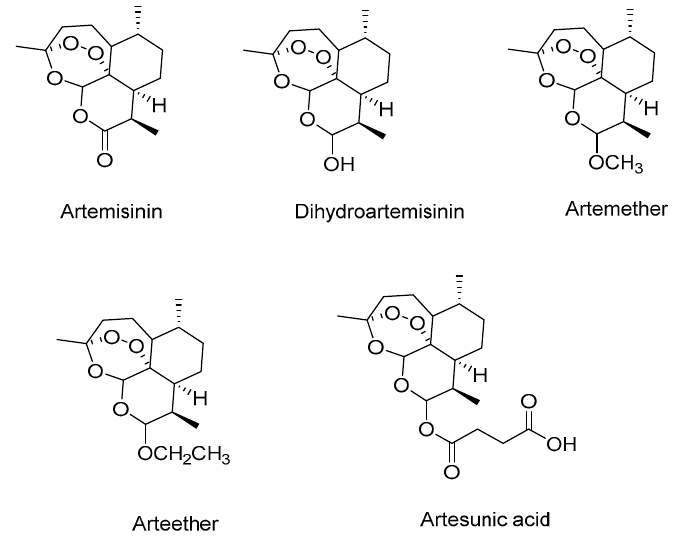
Figure 1. Structures of artemisinin and its semi-synthetic derivatives.